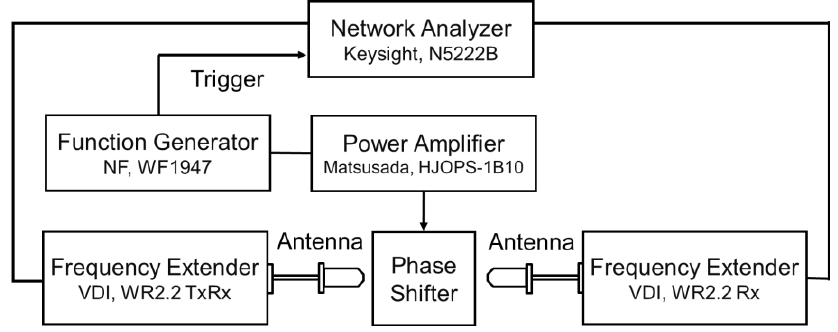
Figure 7. Block diagram of the terahertz wave measurement system.